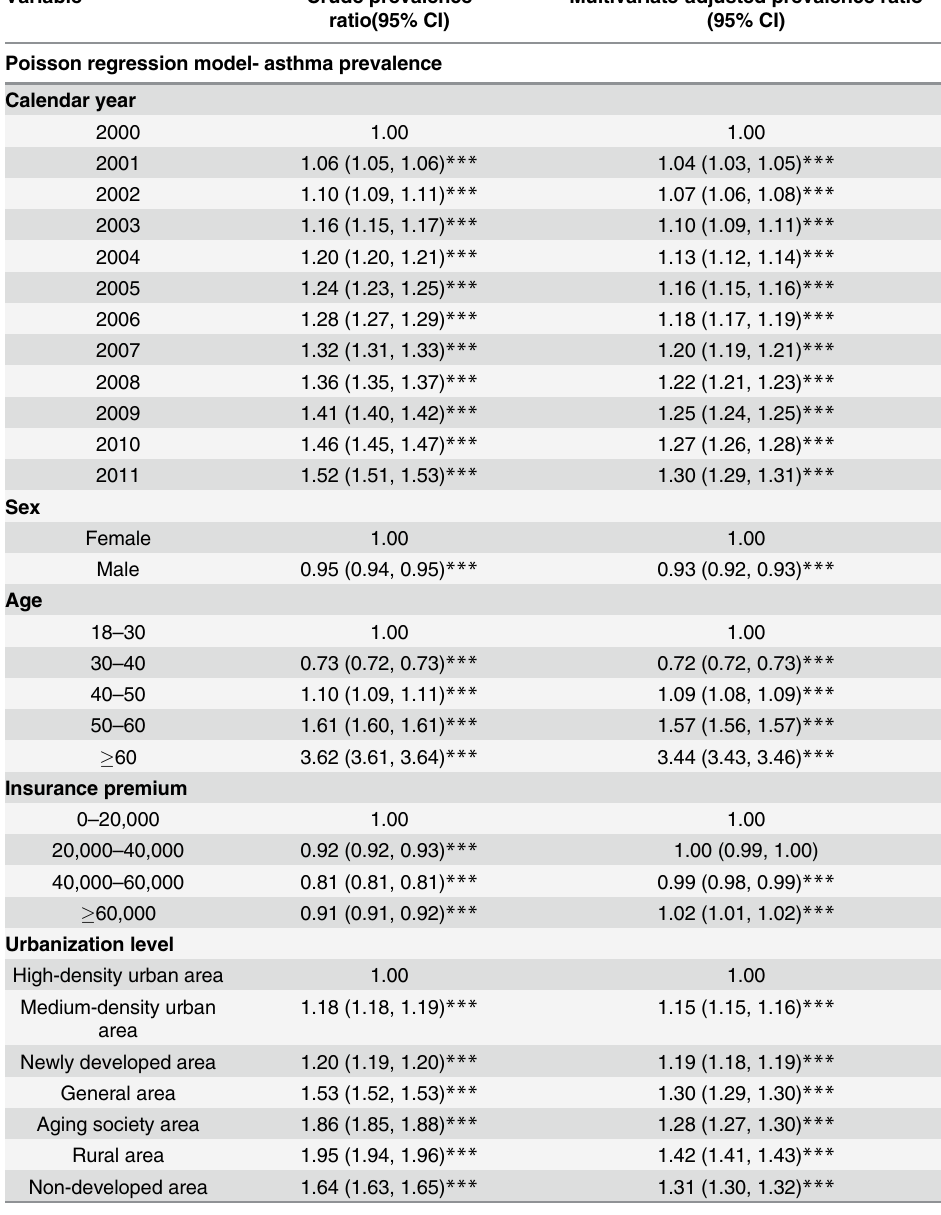
Table 2. Multivariate-adjusted relative risk of annual prevalence of asthma rates for sex, age, time, insurance premium, and urbanization